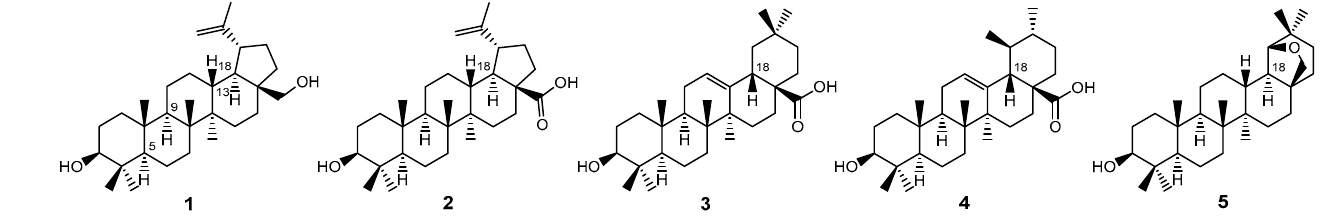
Figure 1. Structures of natural pentacyclic triterpenes.